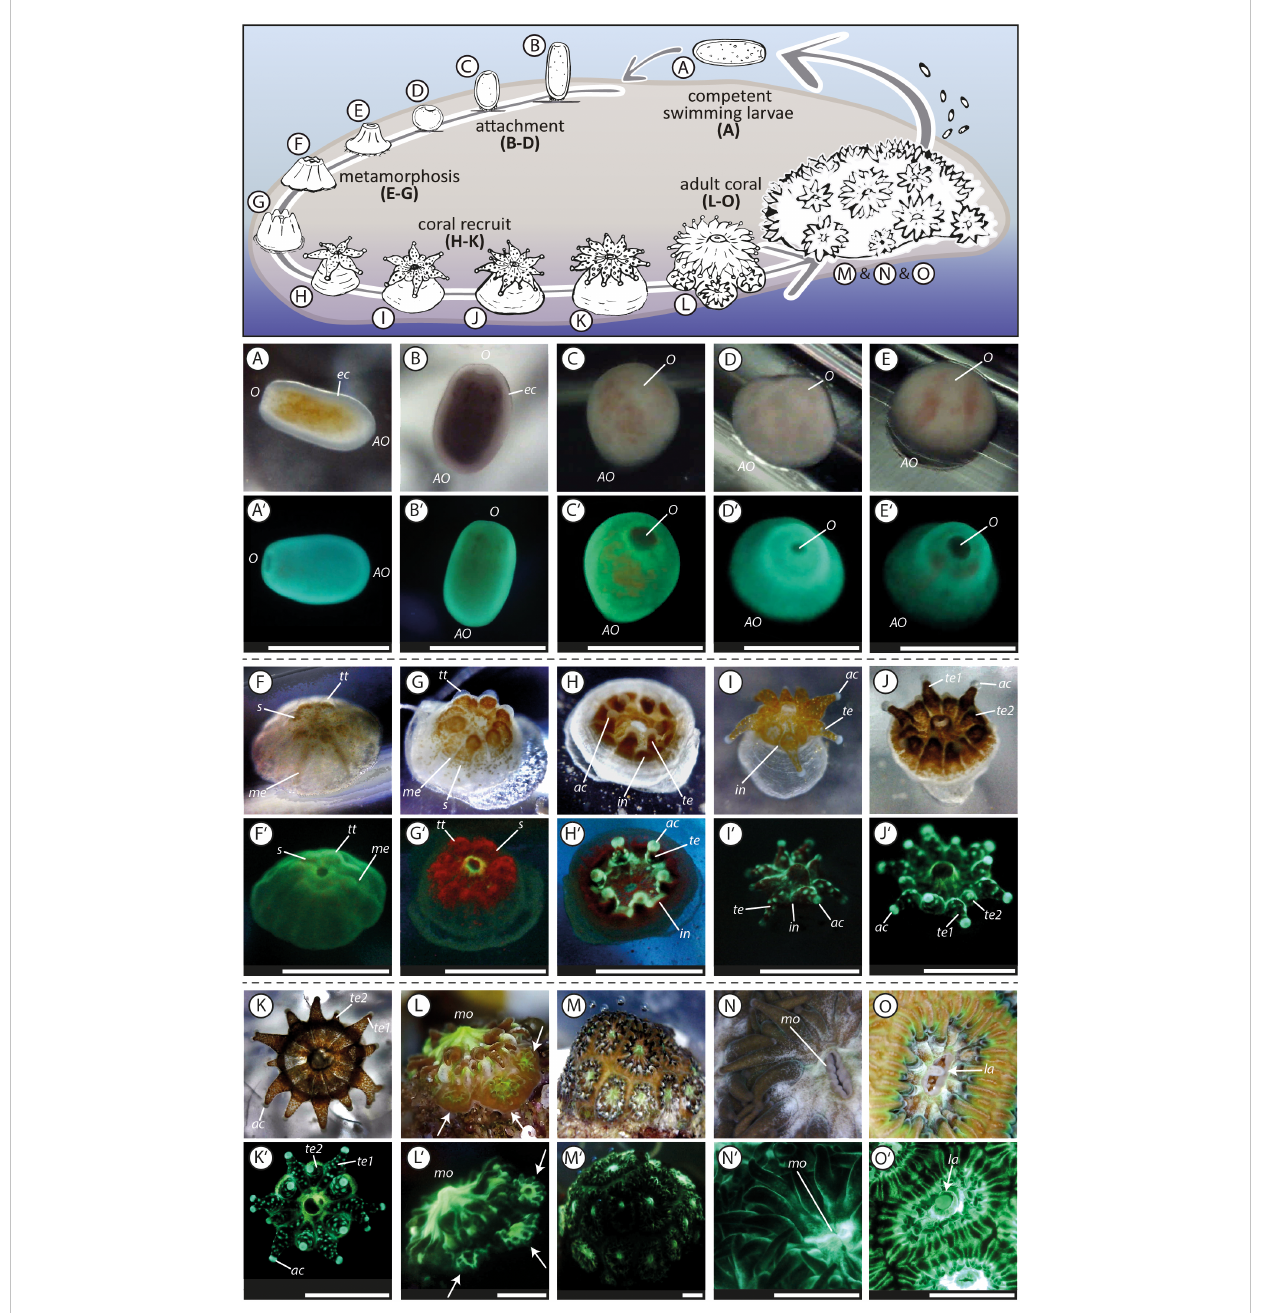
FIGURE 2 Life cycle of the brooding scleractinian coral Leptastrea purpurea (A, A ’– O, O ’ ) . The fi rst pictures (A, A ’ ) were taken directly after larvae collection, the pictures (K, K ’ ) of a juvenile polyp with 12 tentacles were taken 50 days after the initiation of the settlement experiment, the pictures (L, L ’ ) of an juvenile coral, that started to form a colony by extra-tentacular budding, were taken after 130 days, pictures (M, M ’ ) show the whole coral colony that has grown for one year, pictures (N, N ’ ) show polyps of parental colonies and (O, O ’ ) captured the release of brooded coral larvae trough the mouth of the adult polyp. The two pictures with the same letter indicate the same settlement stage but taken with a different light set-up. The picture with the plane letter was taken using white LED light, whereas the picture containing letter and apostrophe was taken using solely blue light (wavelength: 430-460 nm) and the emitted light was captured through a yellow barrier fi lter (see Figure S1). O, oral region; AO, aboral region; ec, ectoderm; s, symbionts; tt, tentacle tips; me, mesenteries; te, completely developed tentacle (te1, te2, primary and secondary tentacle); ac, acrospheres; in, interspaces; mo, mouth; la, larvae. Scale bar: